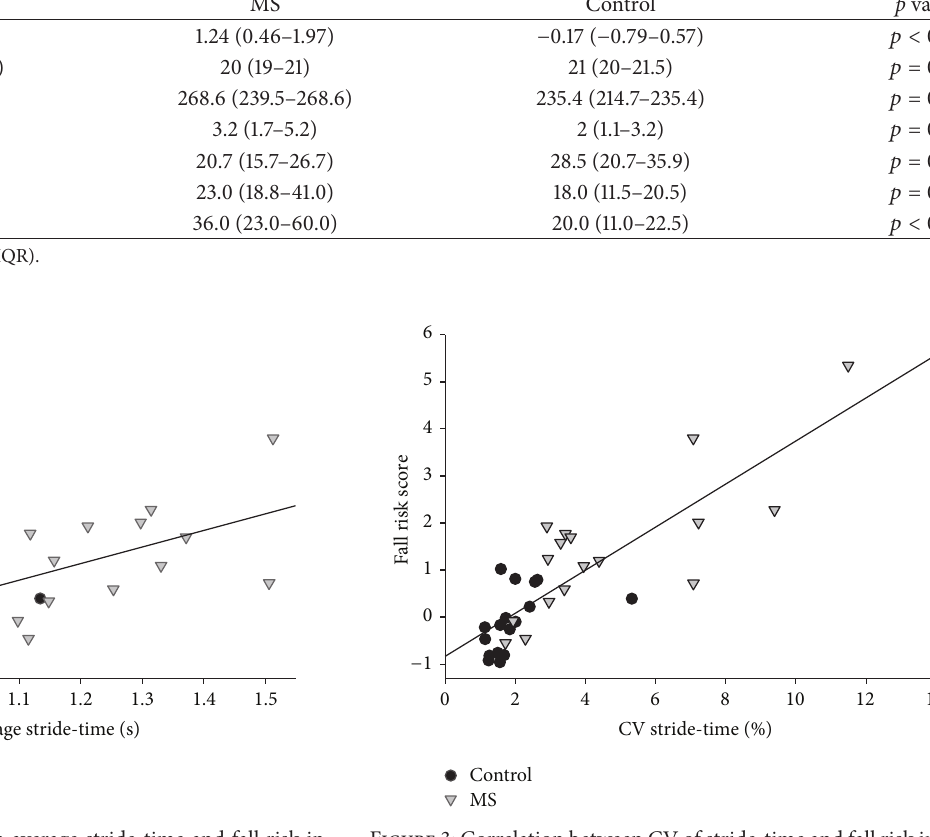
Figure 2: Correlation between average stride-time and fall risk in the MS and control groups.